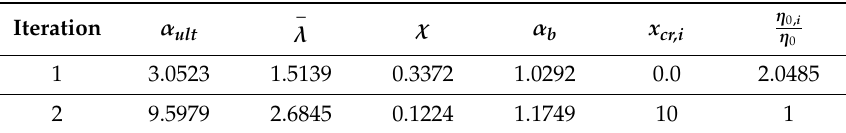
Table 5. Example 5: key values for each iteration.